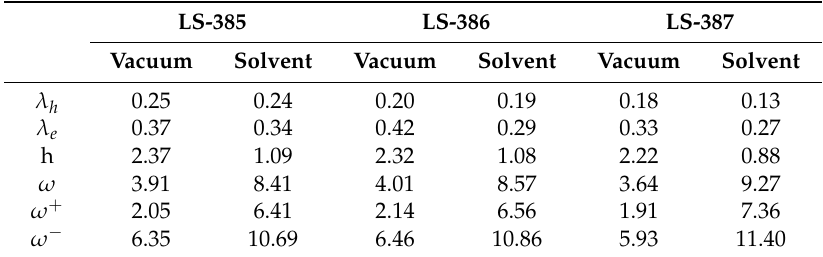
Table 4. The reorganization energy ( λ h and λ e ) and the chemical reactivity parameters λ h and λ e